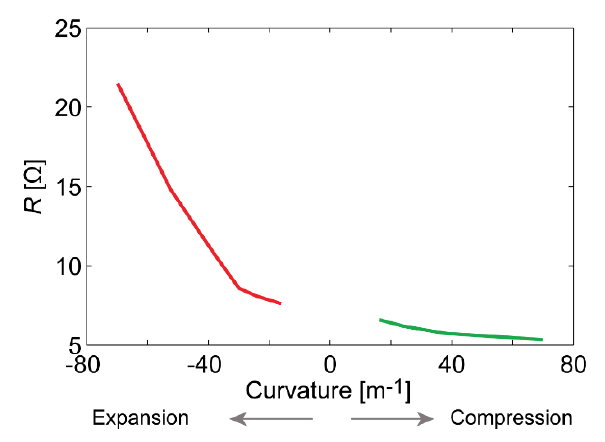
Figure 5. Example of the relation between the curvature and the electrode resistance of an IPMC with platinum